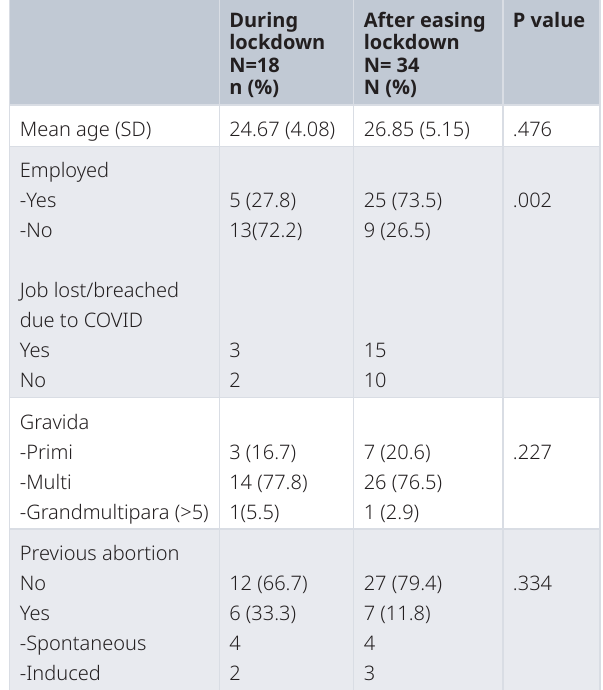
Table 2. Abortion characteristics during the pandemic. During